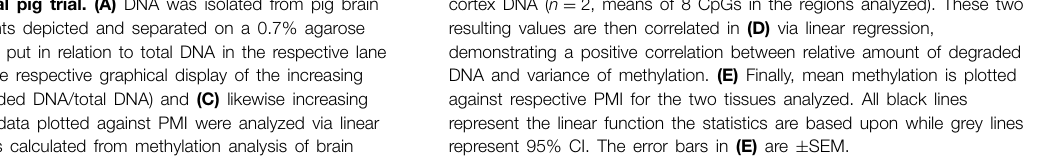
cortex DNA ( n = 2 , means of 8 CpGs in the regions analyzed). These two resulting values are then correlated in (D) via linear regression, demonstrating a positive correlation between relative amount of degraded DNA and variance of methylation. (E) Finally, mean methylation is plotted against respective PMI for the two tissues analyzed. All black lines represent the linear function the statistics are based upon while grey lines represent 95% CI. The error bars in (E) are ±